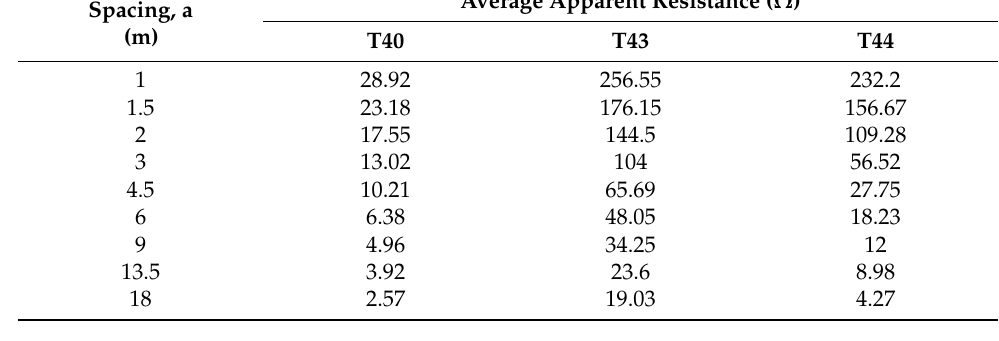
Figure 4. Top view: Apparent resistance measurements at different location areas ( a ) Tower T40 ( b ) Tower T43 ( c ) Tower T44.